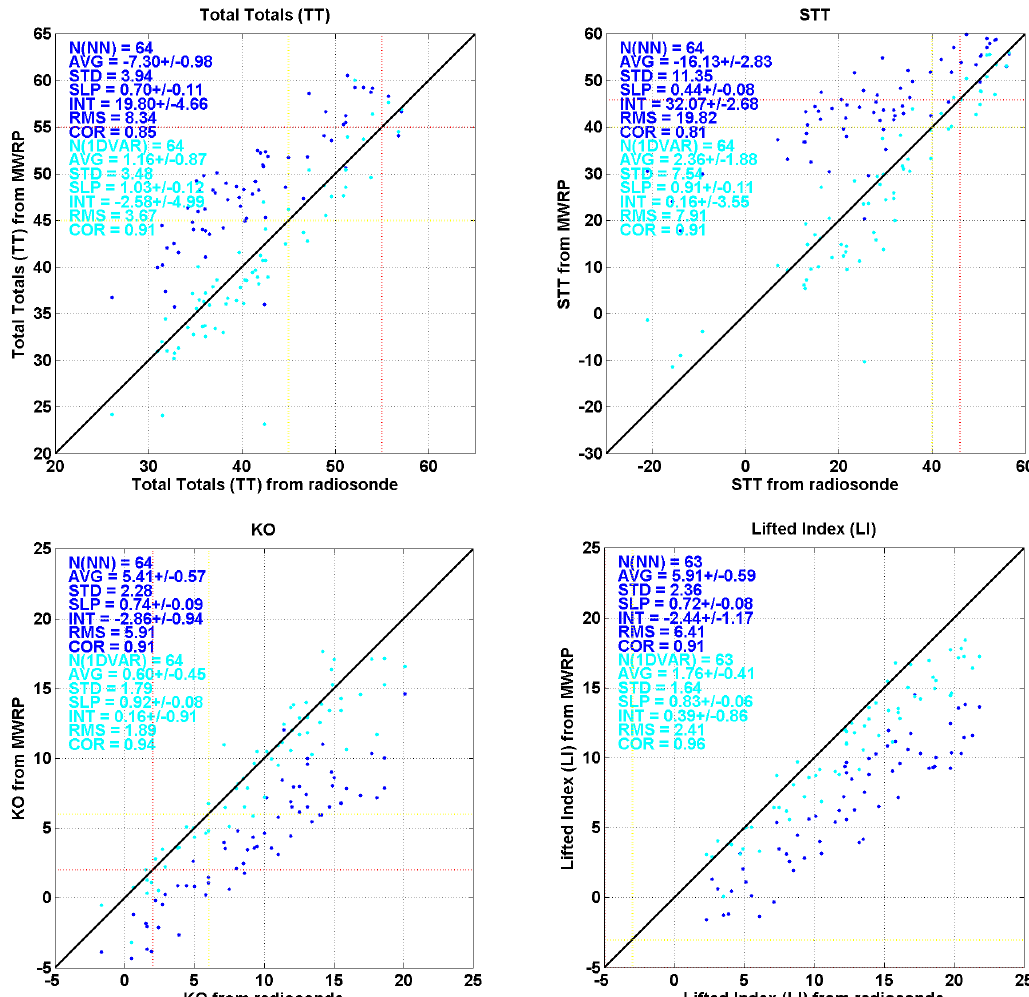
Figure 8. As in Fig. 6 but for (clockwise from top-left panel) total totals, STT, KO, and lifted index. Dotted yellow and red lines indicate thresholds for moderate and high potential, respectively (where